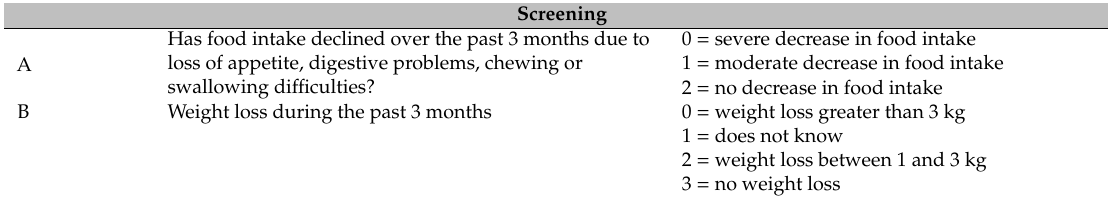
Table A1. MNA full screening